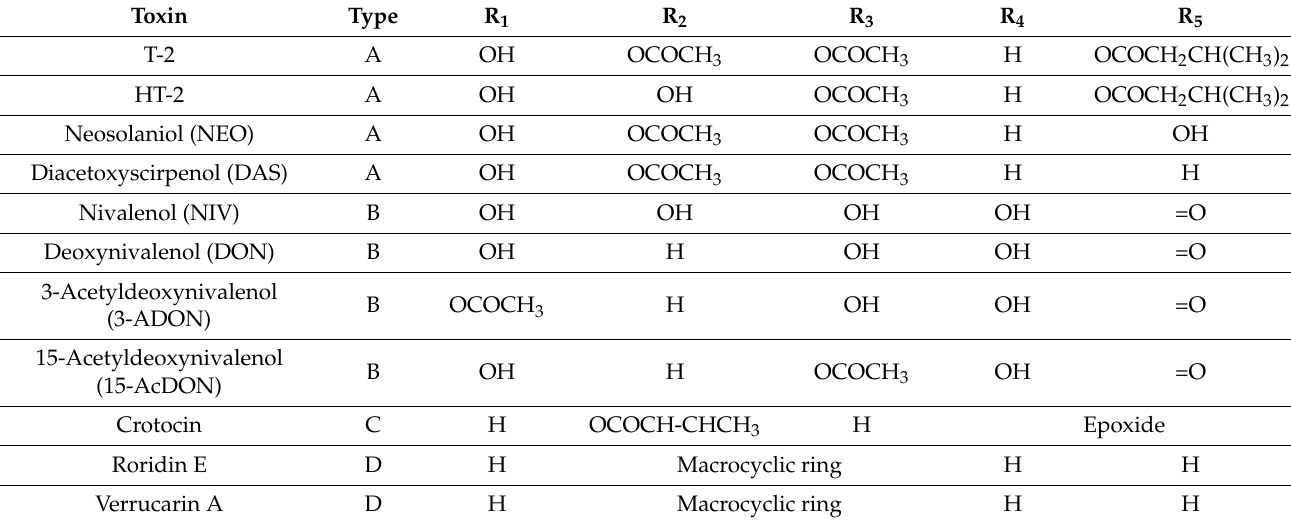
Figure 1. The core structures for A, B, C, and D trichothecenes (TCT) types. Table 1. Substitution pattern of EPT of common trichothecenes (TCT).